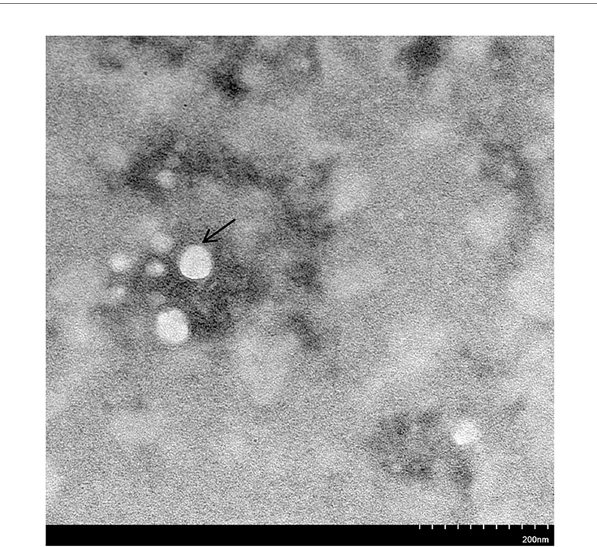
FIGURE 3 Virus particles under the electron microscope. The Black arrow indicates the novel goose astrovirus virion, which is spherical without an envelope and 23 nm in size. Original magnification: × 50,000. Bar: 200 nm.